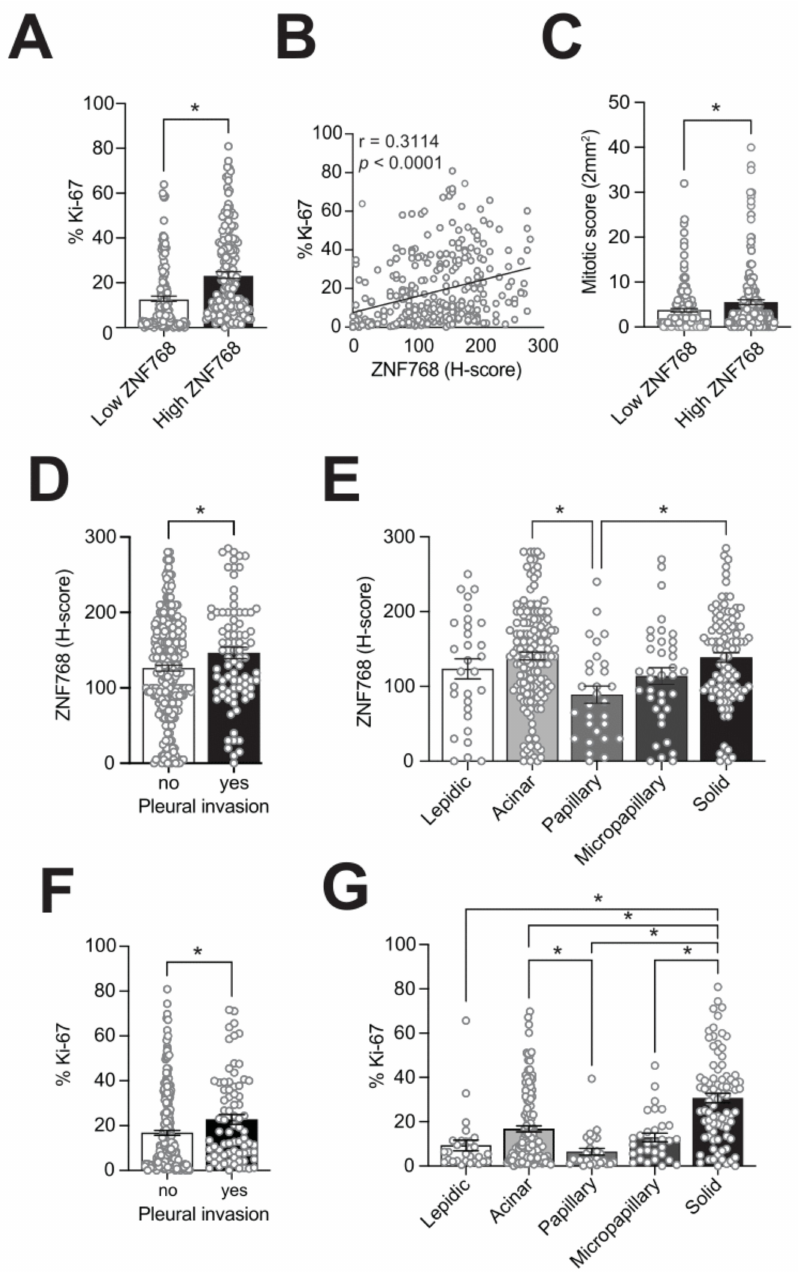
Figure 2. ZNF768 expression associates with proliferative clinicopathological features in LUAD. ( A ) Tumors were separated in high and low ZNF768 expressing groups based on the H-score of the tumor (low, ZNF768 H-score ≤ 130; high, ZNF768 H-score > 130). Difference in the Ki-67 percentage between high and low ZNF768 expressing groups. ( B ) Correlation between the ZNF768 H-score and the percentage of Ki-67 positive cells. ( C ) Difference in the mitotic score between high and low ZNF768 expressing groups. ( D ) Differential expression of ZNF768 in the tumors with pleural invasion. ( E ) ZNF768 expression in the different histological patterns of the tumors. ( F ) Differential percentage of Ki-67 positive cells in the tumors with pleural invasion. ( G ) Ki-67 percentage in the different histological patterns of the tumors. Significance was determined by Spearman’s correlation, t -tests (2 variables) or ANOVAs (< 2 variables) depending on the nature of the factors (* p <